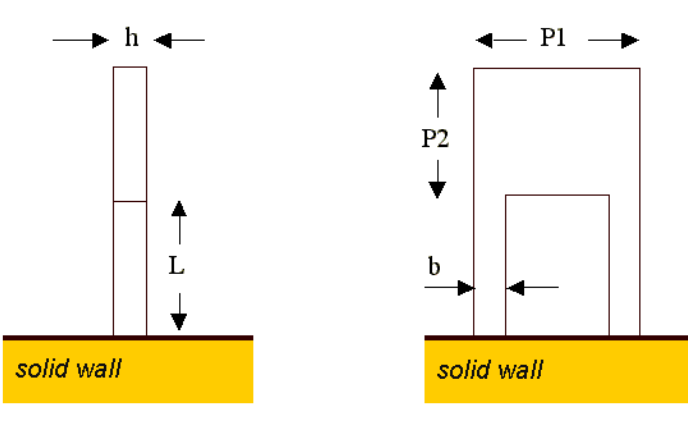
Figure 7. Mechanical structure of a single resonant